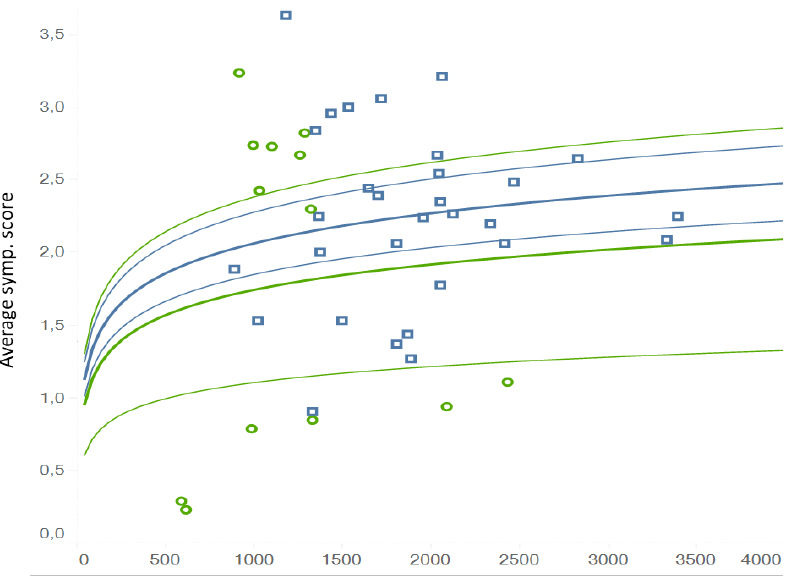
Figure 14. General average related symptoms’ scores relation with indoor CO 2 grouped by measured classrooms (green for middle season and blue for winter).